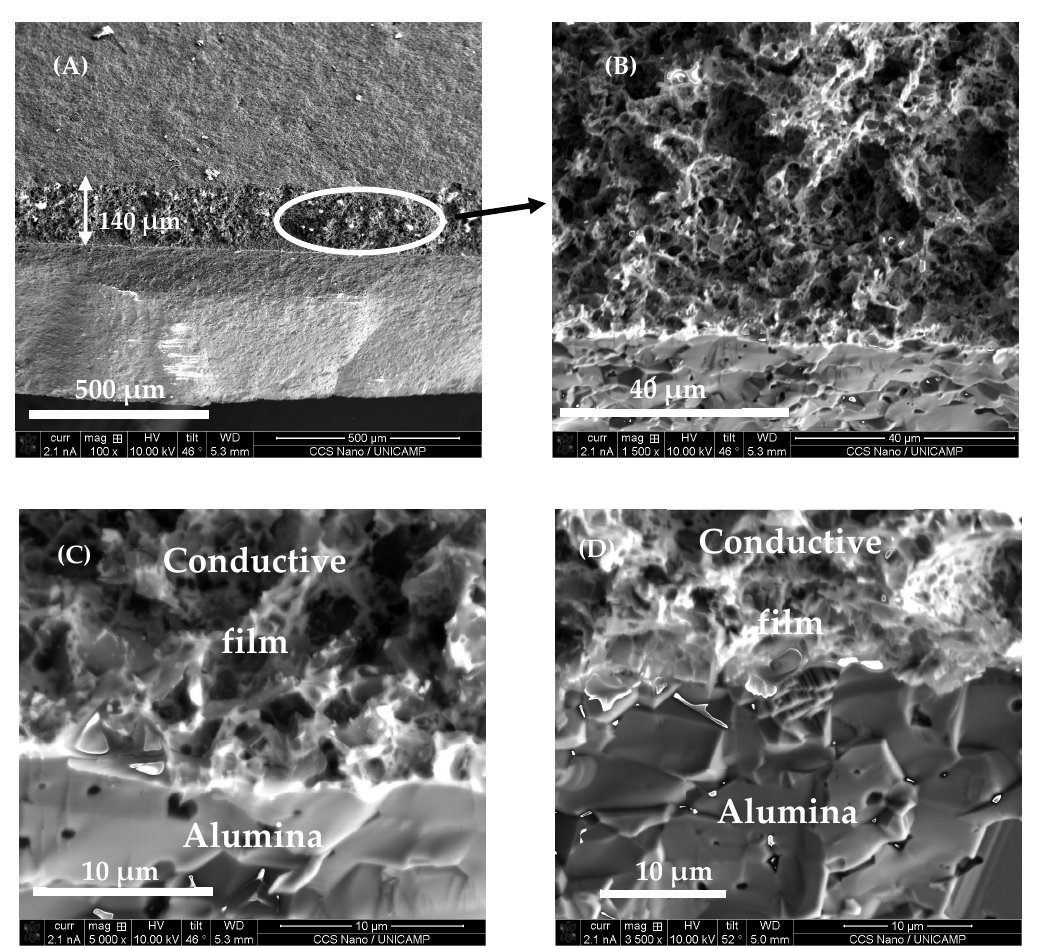
Figure 7. Scanning electronic microscopy image of the fractured piezoresistive film cross-section ( A , B ) and the interface between conductive film and alumina ( C , D ). Scale bars 500 μ m ( A ), 40 μ m ( B ), 10 μ m ( C ) and ( D ).